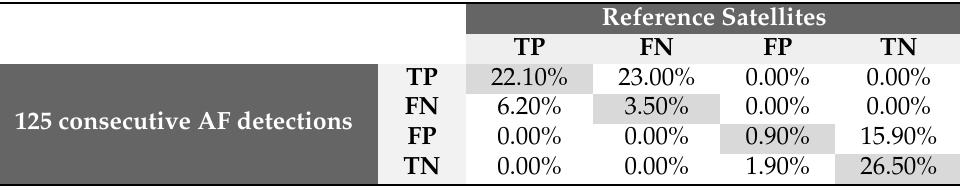
Table 4. Agreement between the Final Model (FM) and the reference satellites (MODIS and VIIRS). True Positive (TP); True Negative (TN); False Positive (FP); False Negatives (FN).